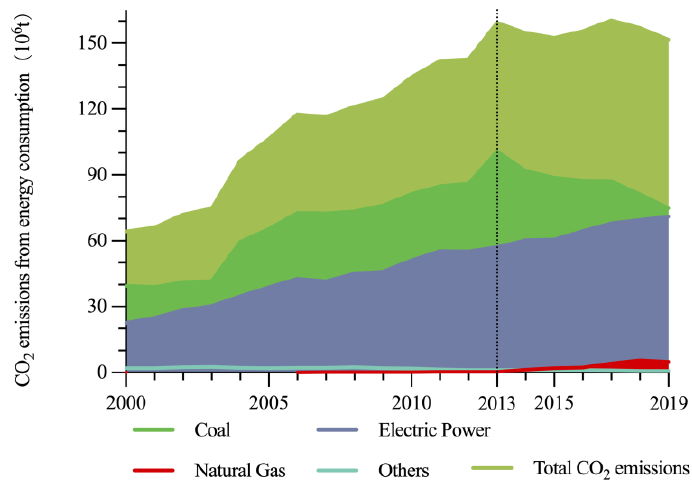
Figure 4. CO 2 emissions from energy consumption in the pulp and paper stage.